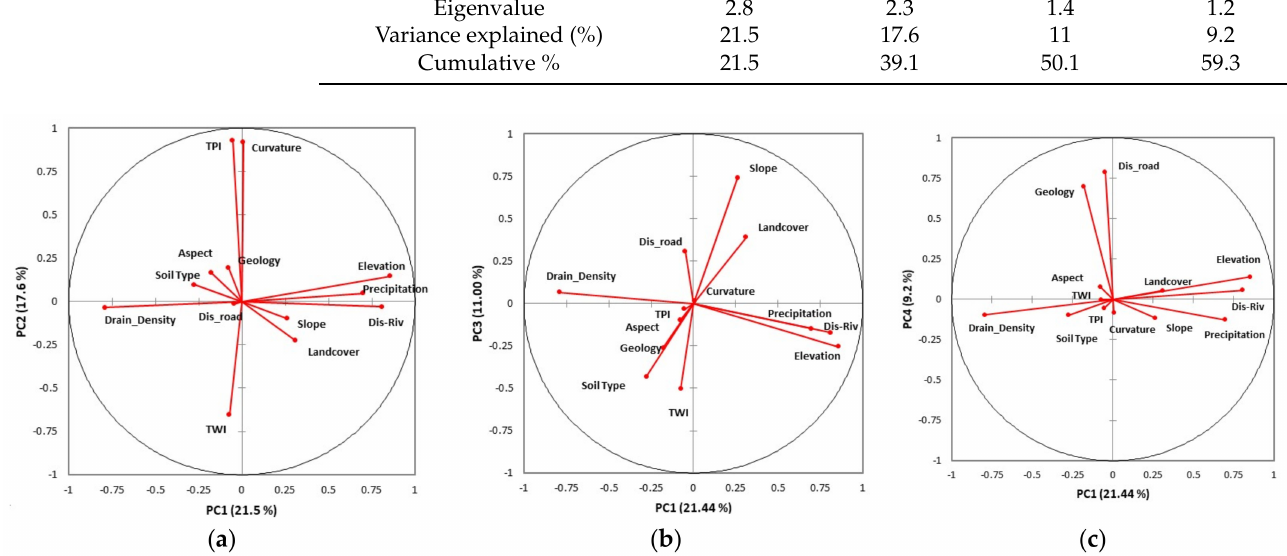
Figure 5. Distribution of parameters on the first three factorial plans ( a – c